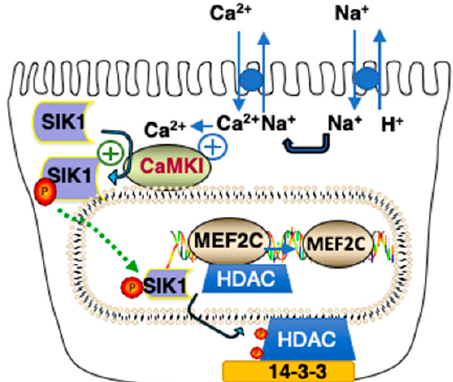
Figure 3. Model of Class IIa HDAC Kinase Phosphorylation by SIK1. An increase in Na + in results in an increase in Ca 2 + in due to activation of Na + / Ca 2 + exchange activity. SIK1 is phosphorylated at Thr322 by CAMK1 and activated, resulting in the phosphorylation of Class IIa HDACs associated with MEF2 transcriptions (as well as NFAT, not shown) on chromosomal DNA. As a consequence of their phosphorylation at two sites (Ser259 and Ser498 in the case of Human HDAC5), Class IIa HDACS translocate to the cytoplasm where they interact with 14-3-3 proteins. If the indicated reaction has a positive e ff ect upon activity, it is indicated by a plus contained within a circle.